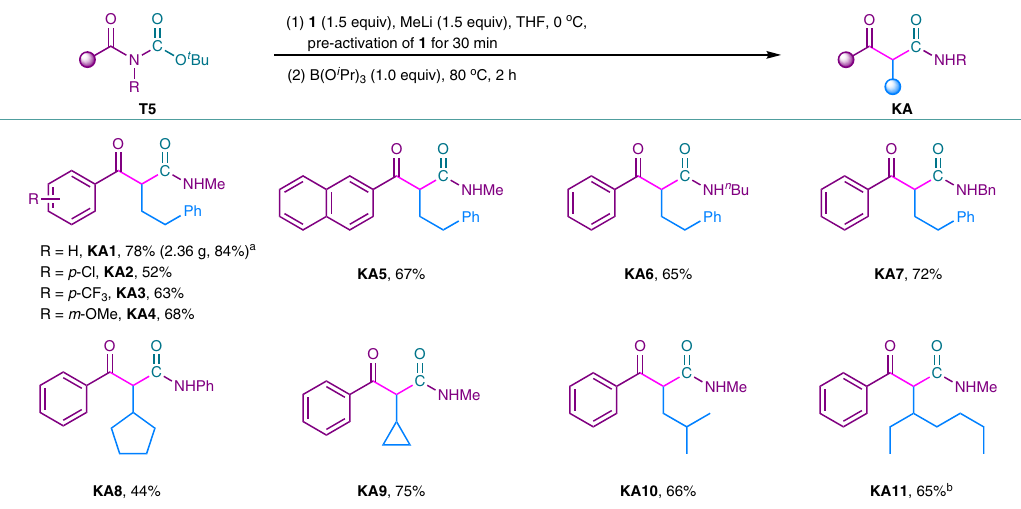
Fig. 7 Synthesis of β -ketoamides via transformation of N -Boc amides using 1,1-diborylalkanes. Reaction conditions: 1 (0.45 mmol), MeLi (0.45 mmol), THF (3.0 mL), 0 °C, 30 min then N -Boc amides T5 (0.30 mmol), B(O i Pr) 3 (0.30 mmol), 80 °C for 2 h. a 10.0 mmol scale. Yields based on isolated products. b The d.r. value was not determined.